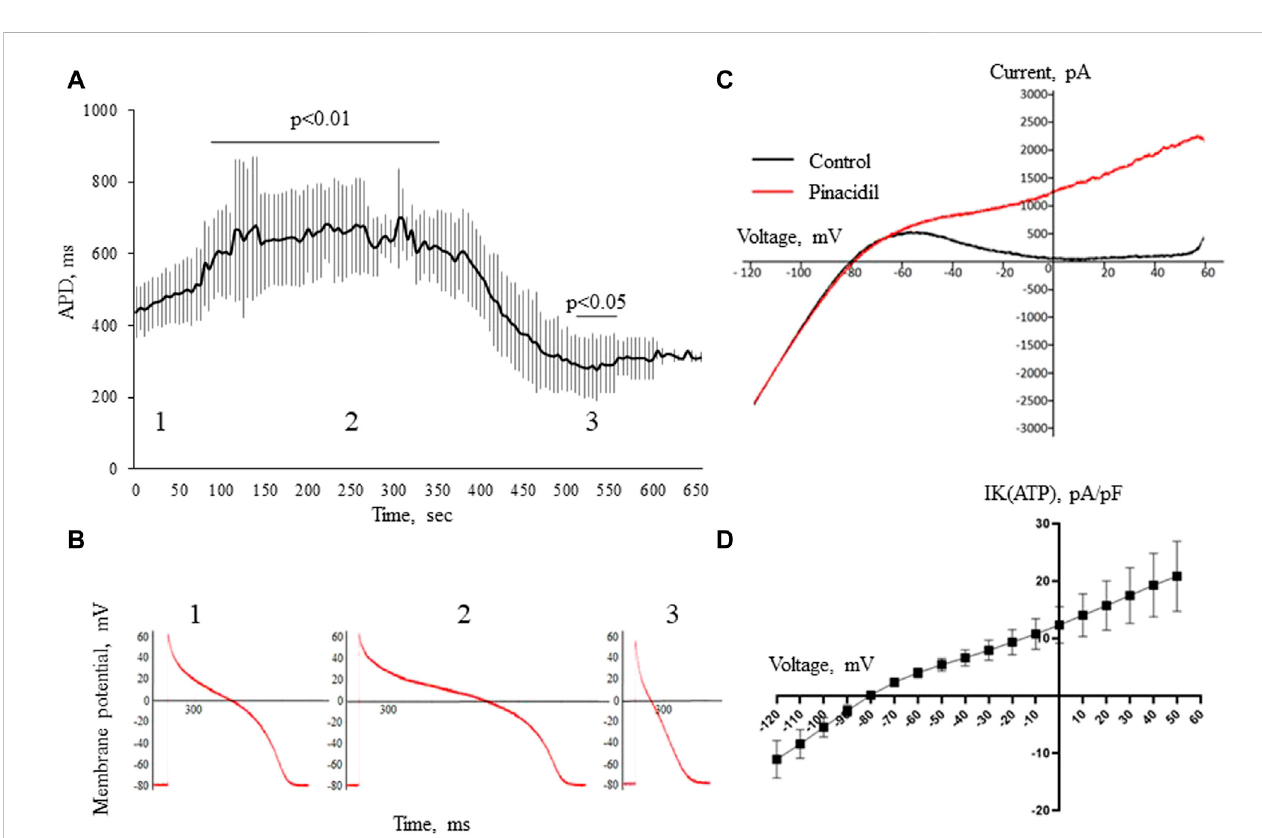
FIGURE 7 The effects of pinacidil. APD changes during the application of pinacidil in whole-cell con fi guration current-clamp (panels (A,B) ). Panel (A) shows a biphasic response in APD after the application of pinacidil with the signi fi cant prolongation during the early period (55 – 385 sec, phase 1) and subsequent shortening (475 – 535 sec, phase 2) as compared to baseline (phase 1). The results are means ± S.E.M. of 6 myocytes from 3 pigs. Panel (B) shows the representativeAPrecordingsatbaseline(1),255th(2)and505th(3)secondsofpinacidilapplication.Panel (C) displaysoriginalcurrentrecordingsinramp protocol in the control solution and after the application of pinacidil. Panel (D) shows a voltage-current curve for IK(ATP) current derived by subtracting the IK1 from the total IKir [IK1 + IK(ATP)] current registered in the presence of pinacidil. The results are means ± S.E.M. of 6 myocytes from 3 pigs.